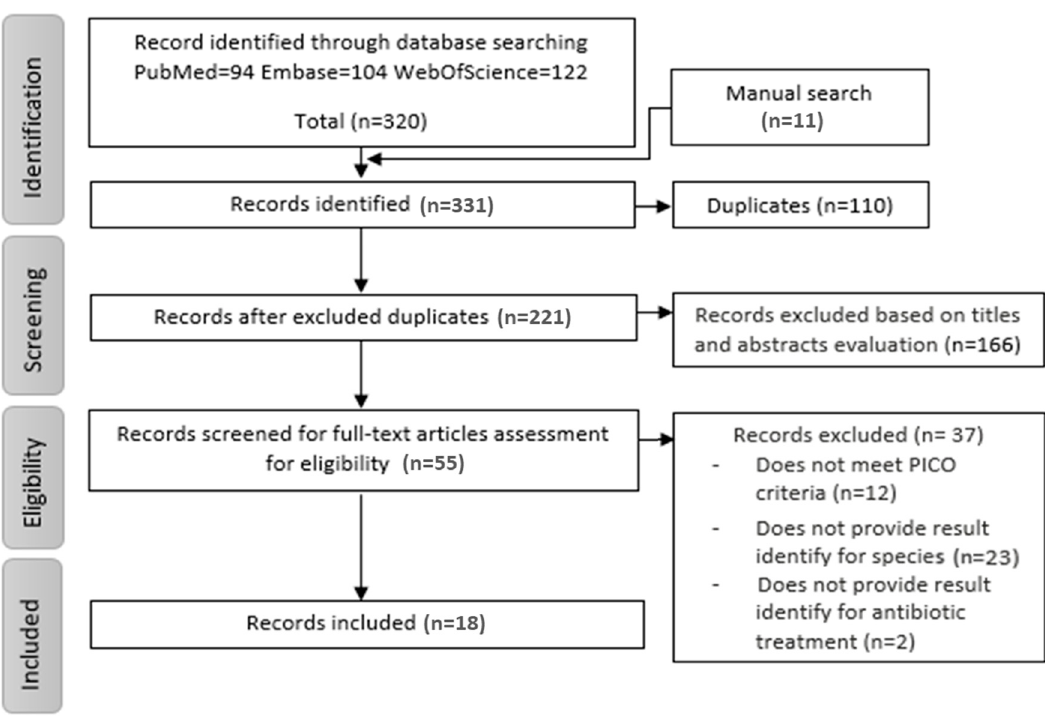
Figure 1. Study selection flowchart.